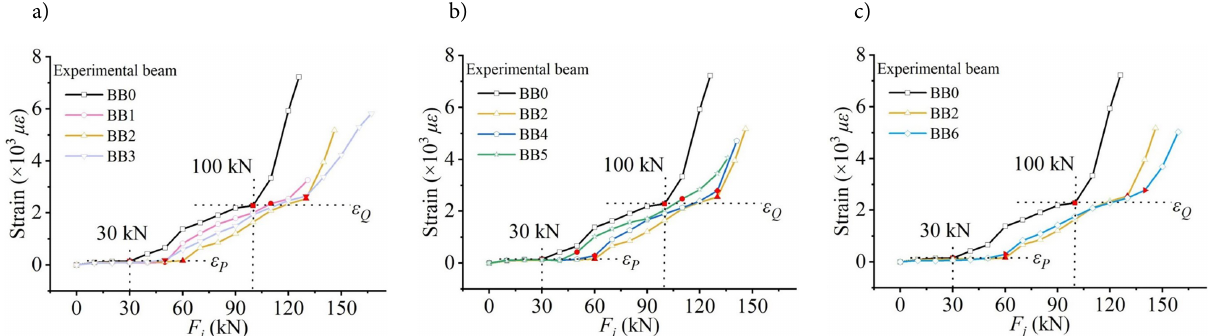
Figure 13. Strain of reinforcement in different experimental beams: a – Experimental beams with different thicknesses of FRP grid; b – Experimental beams with different bond lengths of CRL; c – Experimental beams with different fiber contents